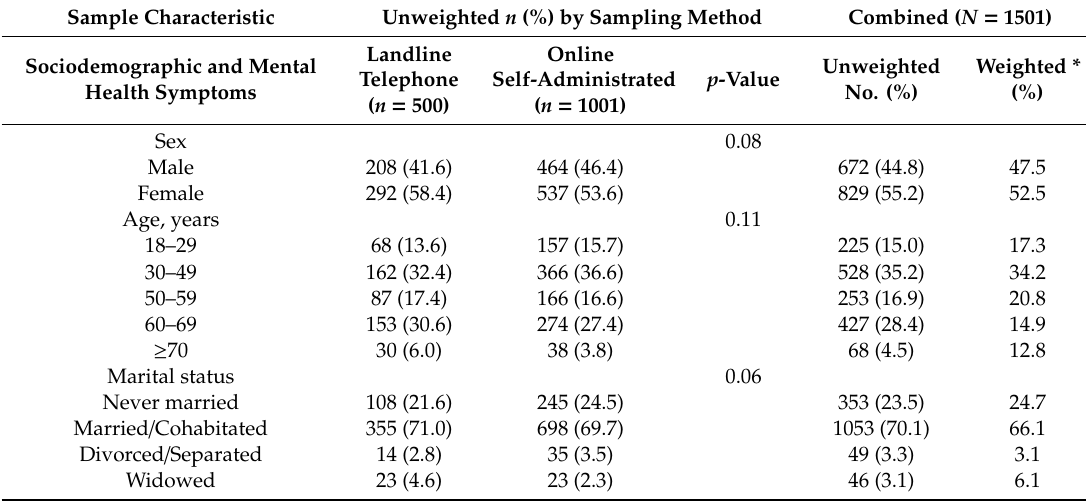
Table 1. Sociodemographic characteristics by sampling